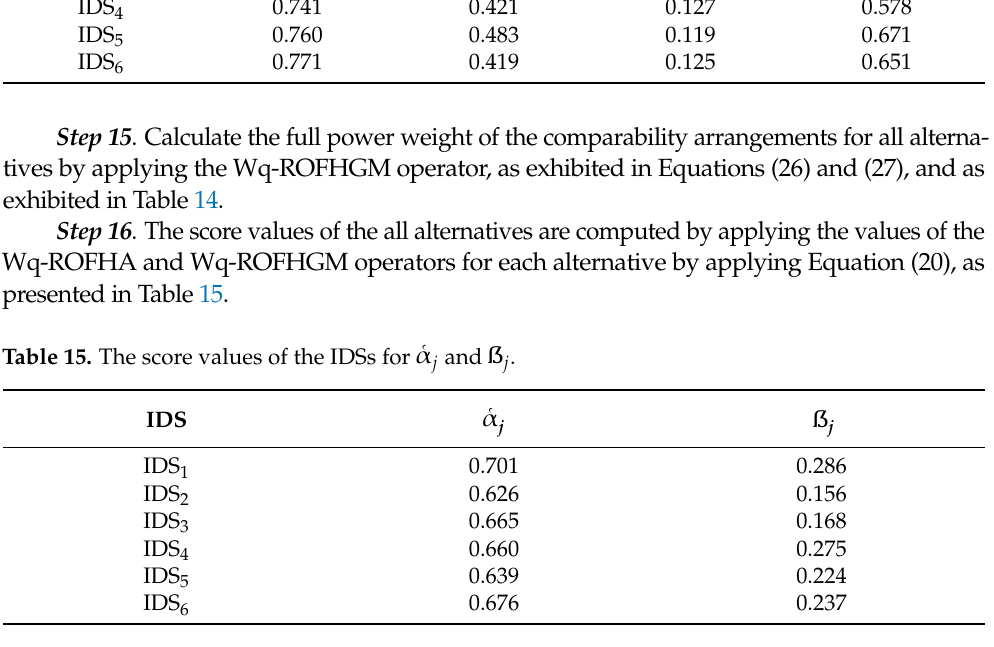
Table 4. Combined evaluation matrix for alternatives in terms of the criteria based on q-ROFN. Alternatives (Intrusion-Detection Systems) Criteria 𝐀